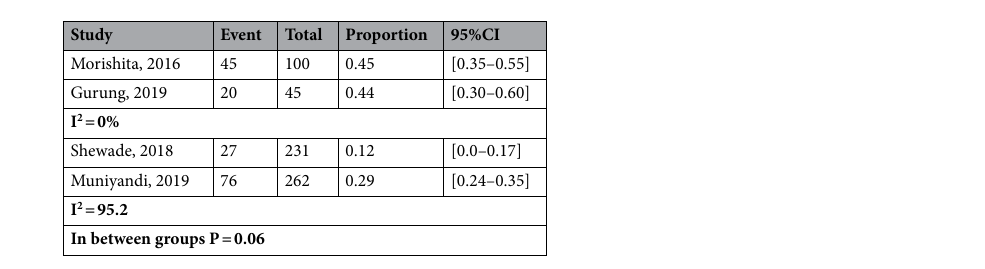
Table 6. Pooled proportion of catastrophic costs at cut-off point of 20% among during passive case finding after sub-group analysis.